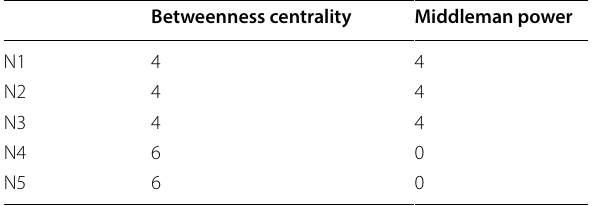
Table 2 The value of un-normalized betweenness centrality and middleman power for the directed network in Fig. 1 Betweenness centrality Middleman